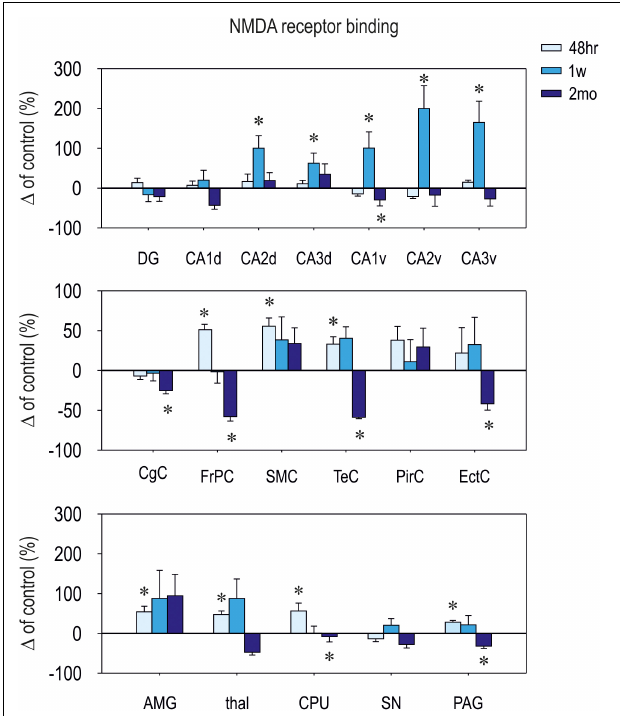
FIGURE 4 | Relative changes in [ 3 H]-M-K801 binding to NMDA receptors (means ± SEM). Binding in control animals is considered as baseline (zero) level. On the top: hippocampal structures; in the middle: cortical structures; on the bottom: (amygdala (AMG), thalamus (thal), caudate putamen (CPU), substantia nigra (SN), and periaqueductal gray (PAG). [ 3 H]-MK-801 binding was assessed at three different intervals (48 h, 1 week, and 2 months – legend on the top) after CZP cessation. DG, dentate gyrus of the hippocampus; CA, CA1 subfield of the hippocampus (d – dorsal, v – ventral); CA3, CA3 subfield of the hippocampus (d – dorsal, v – ventral); CgC, cingulate cortex; FrPc, frontoparietal cortex; SMC, sensorimotor cortex; TeC, temporal cortex; PirC, piriform cortex; EctC, entorhinal cortex.